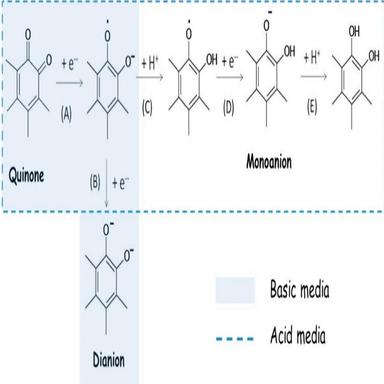
Mechanism of quinone reduction as function of the pH.